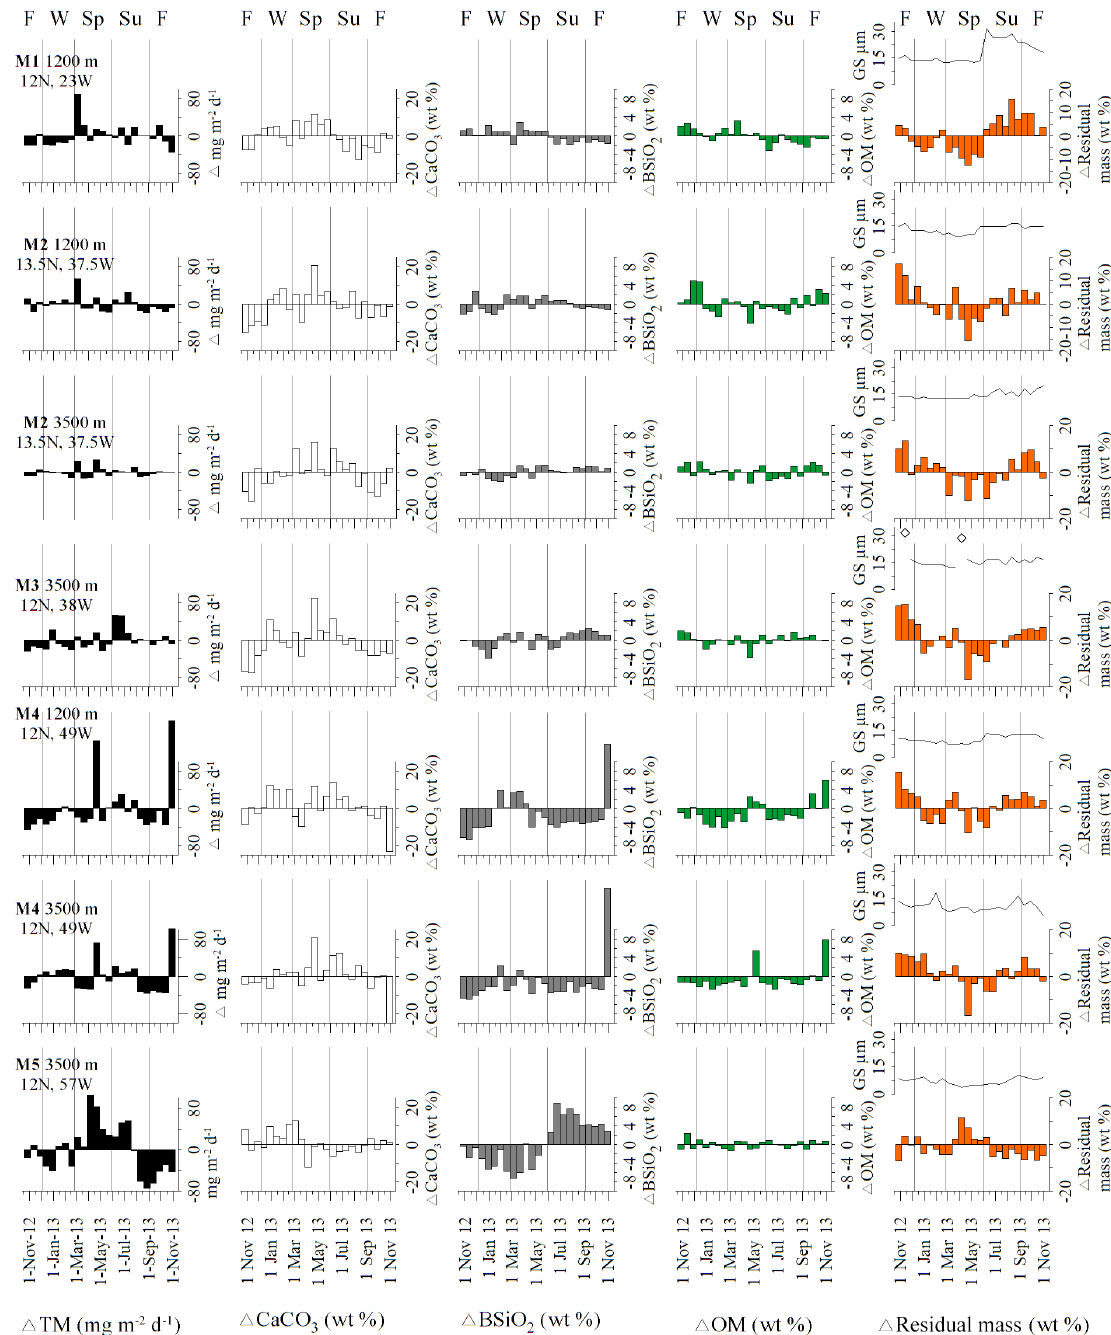
Figure 4. Deviation from the flux-weighted annual mean for total mass (black), CaCO 3 (white), BSiO 2 (grey), organic matter (green) and the residual mass fraction (orange) at ocean sites M1U to M5L. Black lines represent modal grain sizes of Saharan dust of the same sample; diamonds in M3 are outliers (data from Van der Does et al., 2016). F = Fall, W = Winter, Sp = Spring and Su =